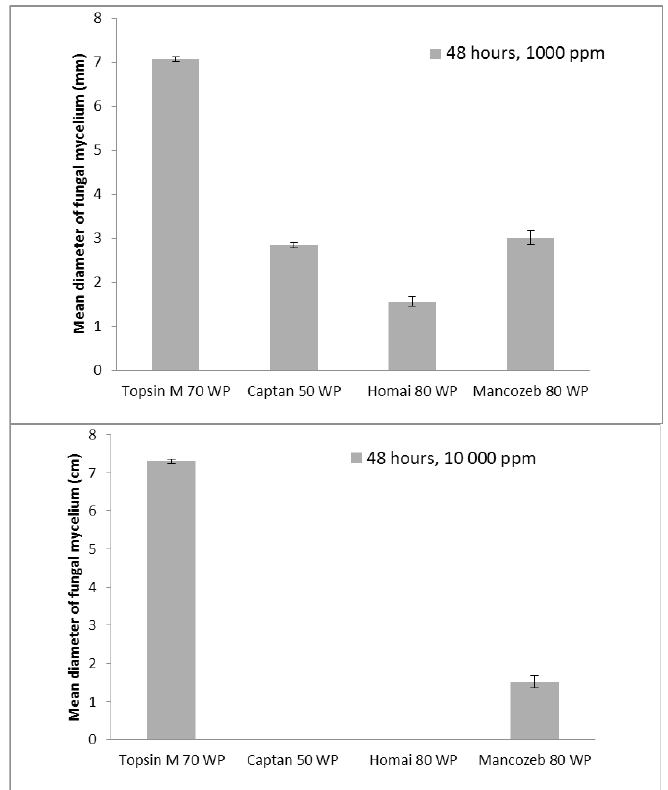
Figure 9: Fungicide sensitivity of P. aphanidermatum (isolate TrI01) against four different fungicides. Radial growth of mycelium in 1000 ppm fungicides after 48 h